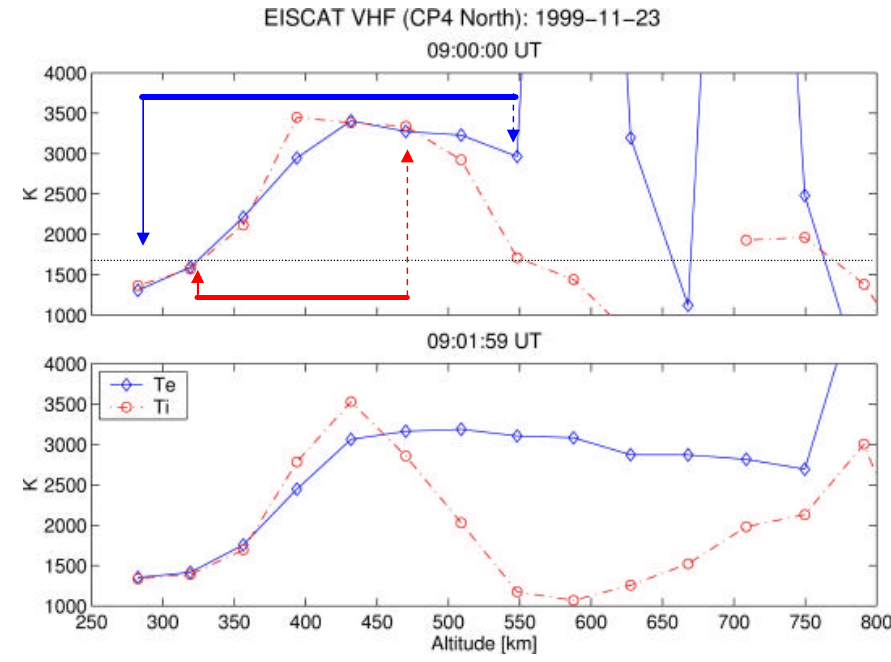
Fig. 6. The T e and T i versus height along EISCAT Beam 1 for 09:00 and 09:01:59UT data records.